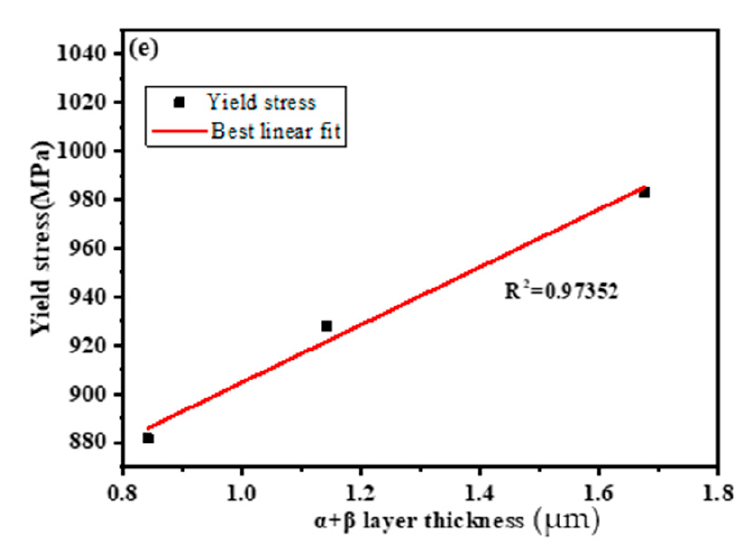
Figure 10. Hall–Petch relationship between yield stress and microstructure parameters including ( a ) Grain size dg, ( b ) α platelet thickness T α , ( c ) α colony thickness Tc, ( d ) thickness of GB TGB, and ( e ) α + β platelet thickness T α + β .